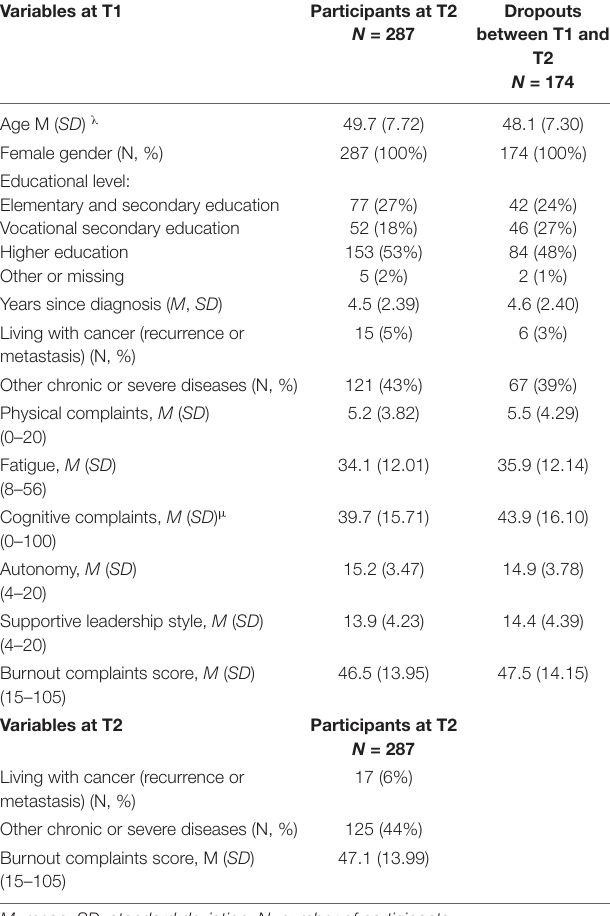
TABLE 1 | Characteristics of participants at T2 ( N = 287) and dropouts between T1 and T2 ( N = 174). Variables at